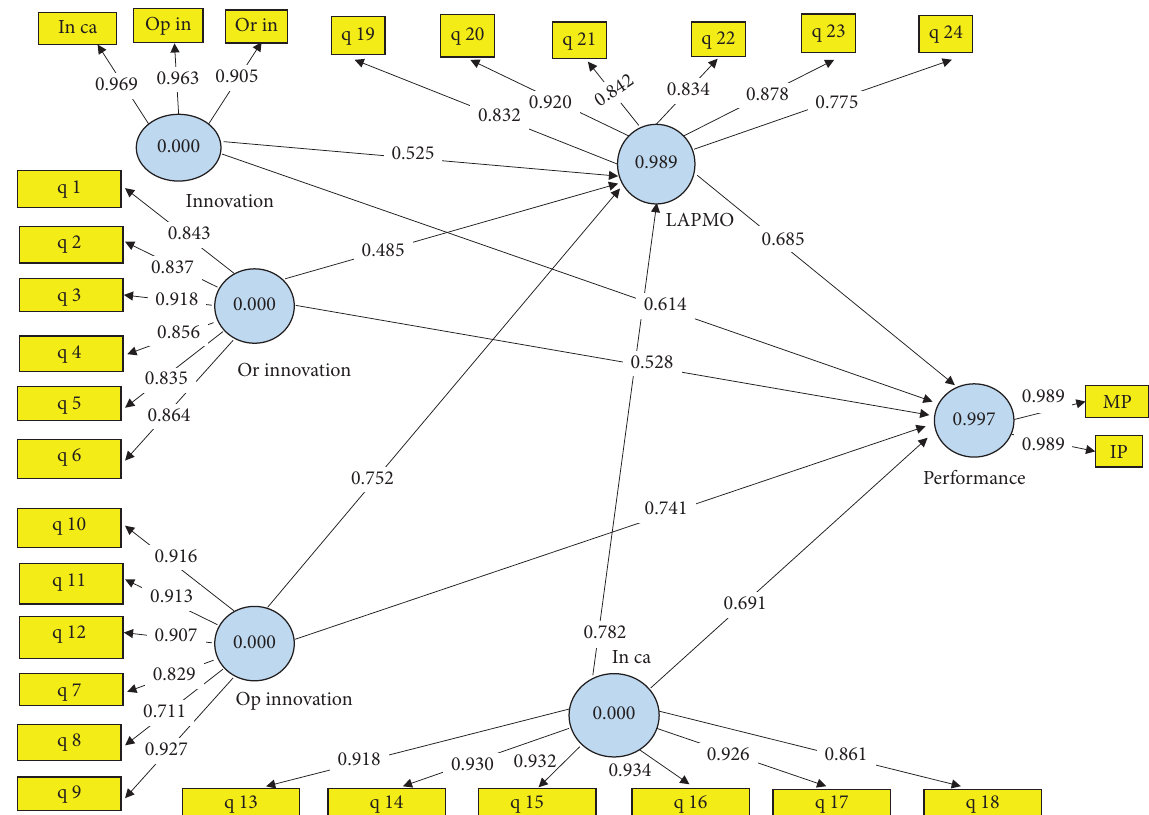
Figure 4: An estimation of standard factor load for the structural equation model of the study (made by